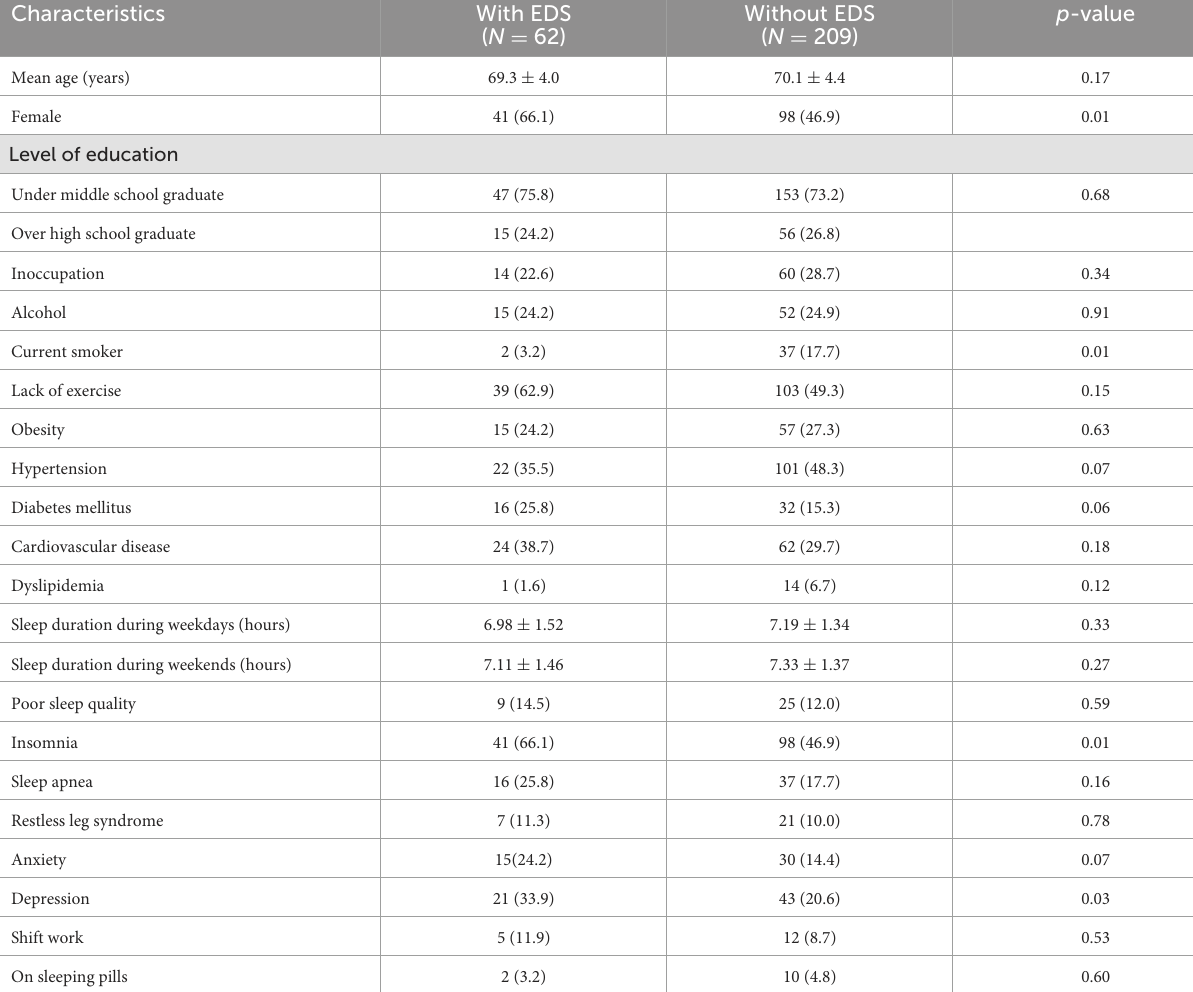
TABLE 3 Comparison between elderly patients with and without excessive daytime sleepiness.